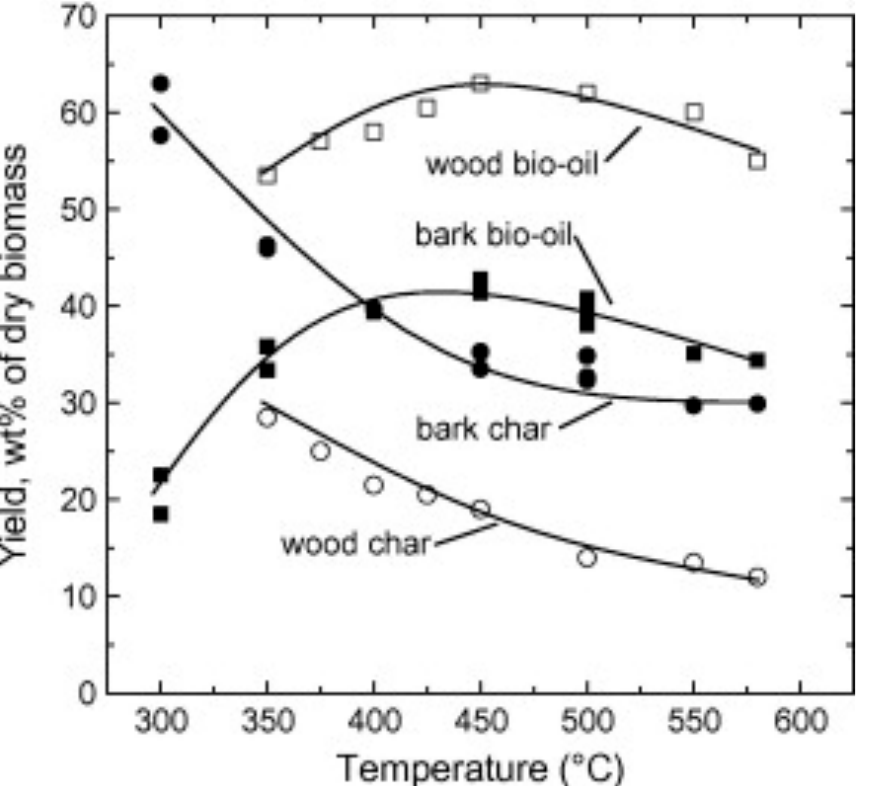
Figure 7. The optimal temperature for maximum bio-oil yield occurs at 450–500 °C (Reprinted with permission from ref. [35]. Copyright 2013 Fuel).